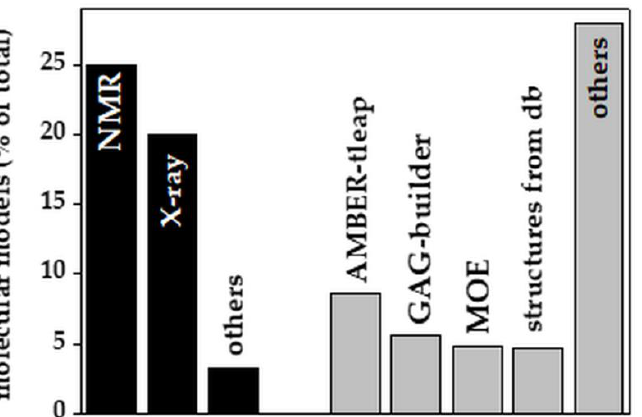
Figure 4. Experimental and computational methods used to generate models of GAGs alone or in complex with their binders. Each bar reports the percentage of papers in which the indicated experimental (black bars) or computational (grey bars) methods were employed. For the software grouped under “others”, see Table 2. db: database. For further details on the bibliographic research strategy, see Appendix A.